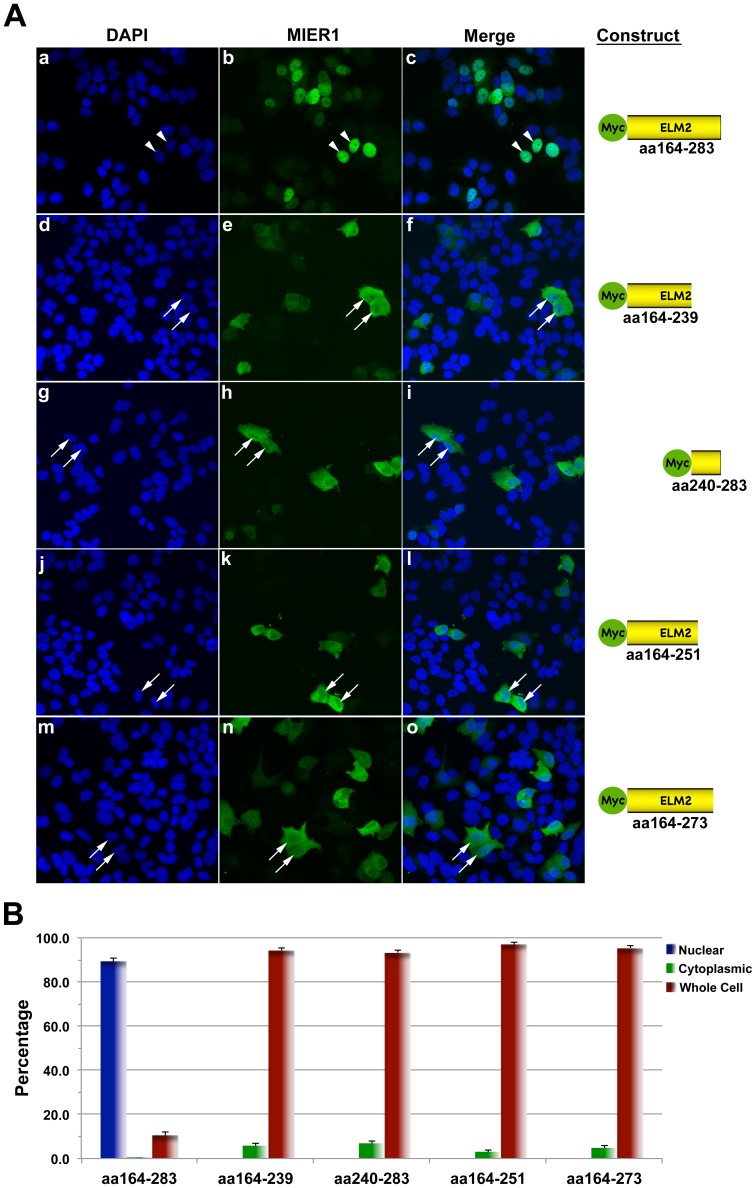
Nuclear localization requires an intact ELM2 domain.MCF7 cells were transfected with a myc-tagged intact ELM2 domain (aa164–283) (panels a-c) or a myc-tagged ELM2 deletion construct containing aa164-239 (panels d-f), aa240-283 (panels g-i), aa164-251 (panels j-l), aa164-273 (panels m-o). Localization was analyzed by confocal microscopy using DAPI and the 9E10 anti-myc tag antibody. (A) Illustrative examples of stained cells showing MIER1α localization. Note that nuclear localization was only detected with an intact ELM2 domain (a-c); arrowheads indicate examples of stained nuclei. The rest of constructs displayed whole cell staining (arrows in d-o). A schematic, drawn to scale and illustrating the constructs used, is shown on the right as are the amino acids (aa) encoded by each construct. The myc epitope tag is shown in green. (B) Histogram showing the results of 3 independent experiments; random fields were selected and the staining pattern of each cell within the field was scored visually. 465-565 cells were scored for each construct. Plotted is the percentage of cells in each category ± S.D; the percent nuclear of all deletion constructs are significantly less than that of the intact ELM2 domain (p<0.05).